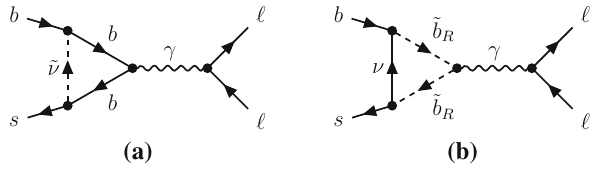
Fig. 2 Photonic penguin diagrams studied in our